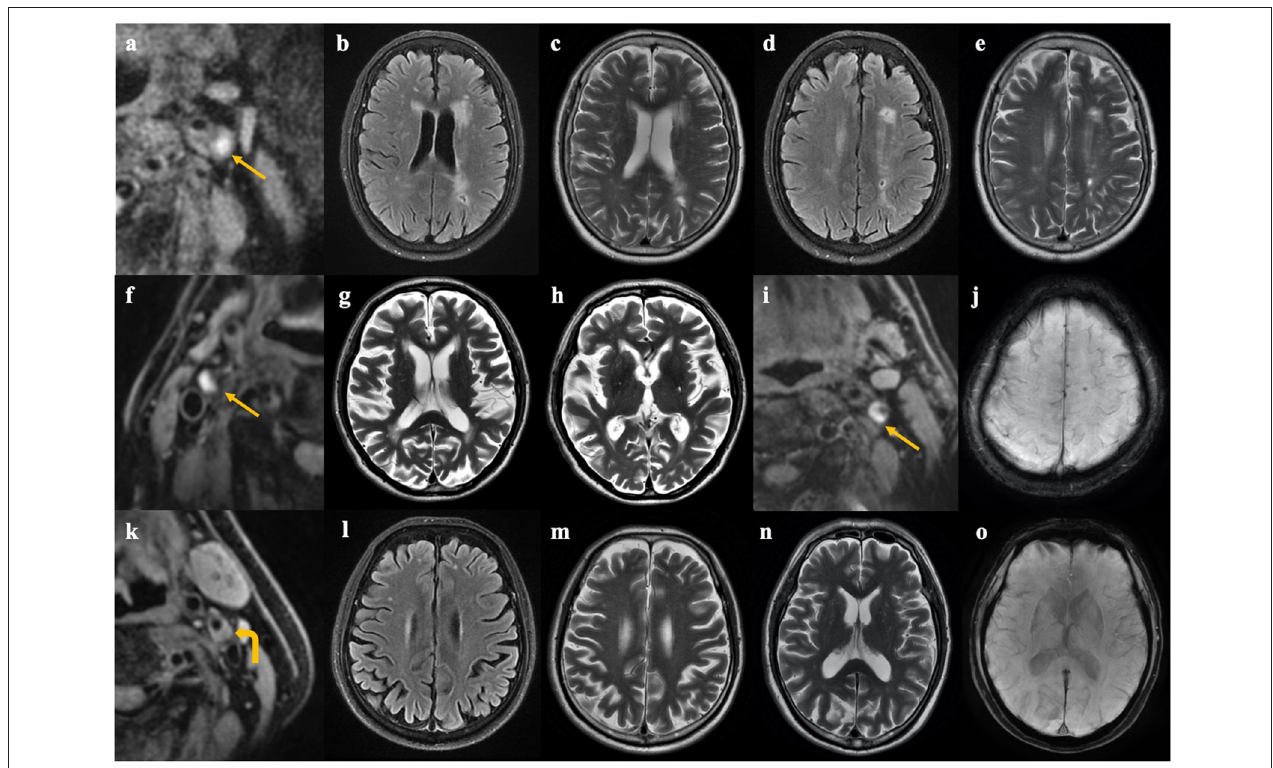
FIGURE 4 | Representative cases of patients with and without unilateral carotid IPH. Case 1 (a–e) . A 68-year-old female complained of weakness of right limbs, and high-resolution MRI for carotid plaque showed carotid intraplaque hemorrhage (IPH) on the left side (a) . Brain MRI showed more severe white matter hyperintensities and lacunes on the left hemisphere than that on the contralateral hemisphere (b–e) . Case 2 (f–h) . An 82-year-old male complained of transient weakness of lower limbs. High-resolution MRI for carotid plaque showed IPH on the right side (f) . Brain MRI showed category-1 perivascular spaces (PVSs) in the left basal ganglia and category-2 PVSs in the right basal ganglia (g,h) . Case 3 (i,j) . An 85-year-old male complained of dizziness for 1 month. High-resolution MRI for carotid plaque showed IPH on the left side (i) , and a cerebral microbleed lesion was found on the ipsilateral hemisphere (j) . Case 4 (k–o) . A 71-year-old male with asymptomatic carotid stenosis. Carotid plaque without hemorrhage on the left side was shown on carotid MRI (k) , and cerebral small vessel disease was symmetrical between two hemispheres (l–o) . Arrow indicates carotid IPH, and curved arrow indicates carotid